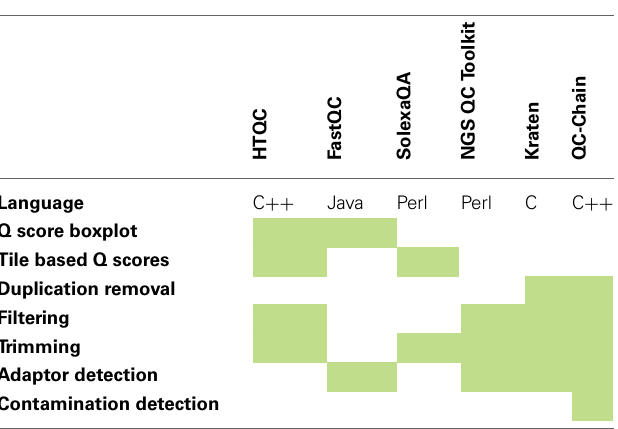
Table 1 | Comparison of features in QC Toolkits.